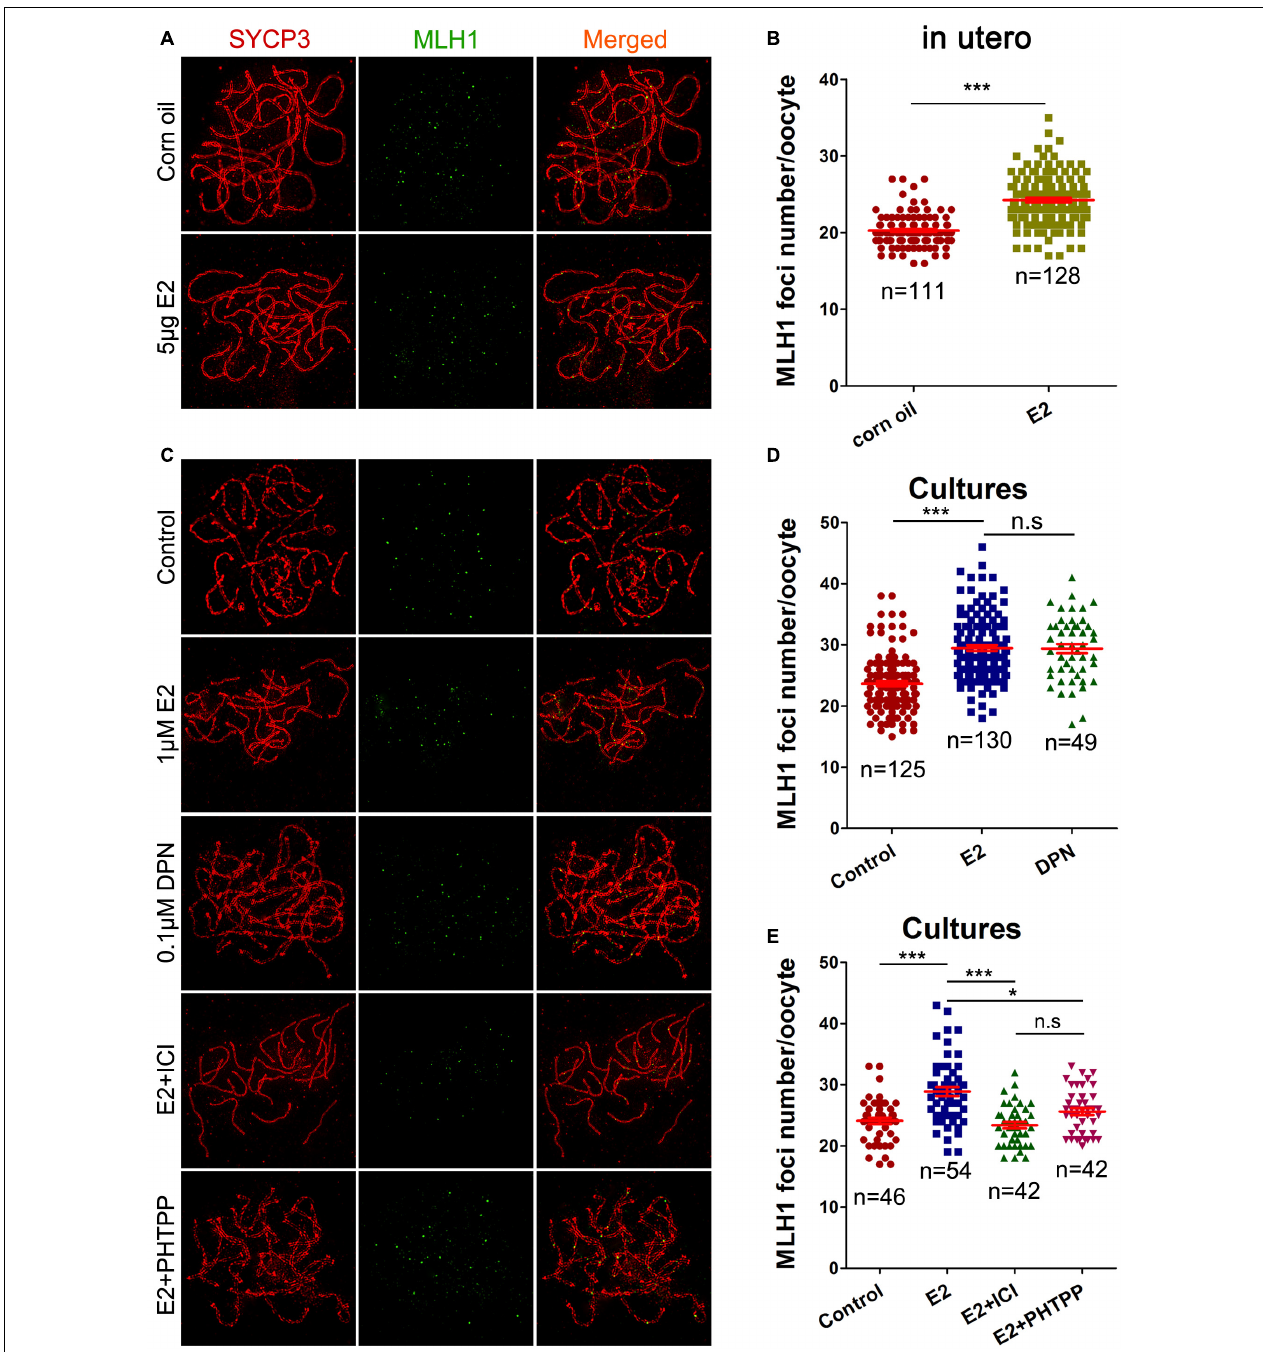
FIGURE 5 | E 2 increases MLH1 foci in fetal oocytes mainly by ESR2. (A,B) : pachytene oocytes received in utero exposure. (A) MLH1 foci were indicated by co-staining of SYCP3 (red) and MLH1 (green). (B) E 2 increased MLH1 foci number. (C–E) : pachytene oocytes from ovary culture. (C) Co-staining of SYCP3 (red) and MLH1 (green). (D) E 2 and DPN increased MLH1 foci number. (E) ICI 182,780 and PHTPP reversed the increased MLH1 counts. * P < 0.05. *** P < 0.001. n.s: not